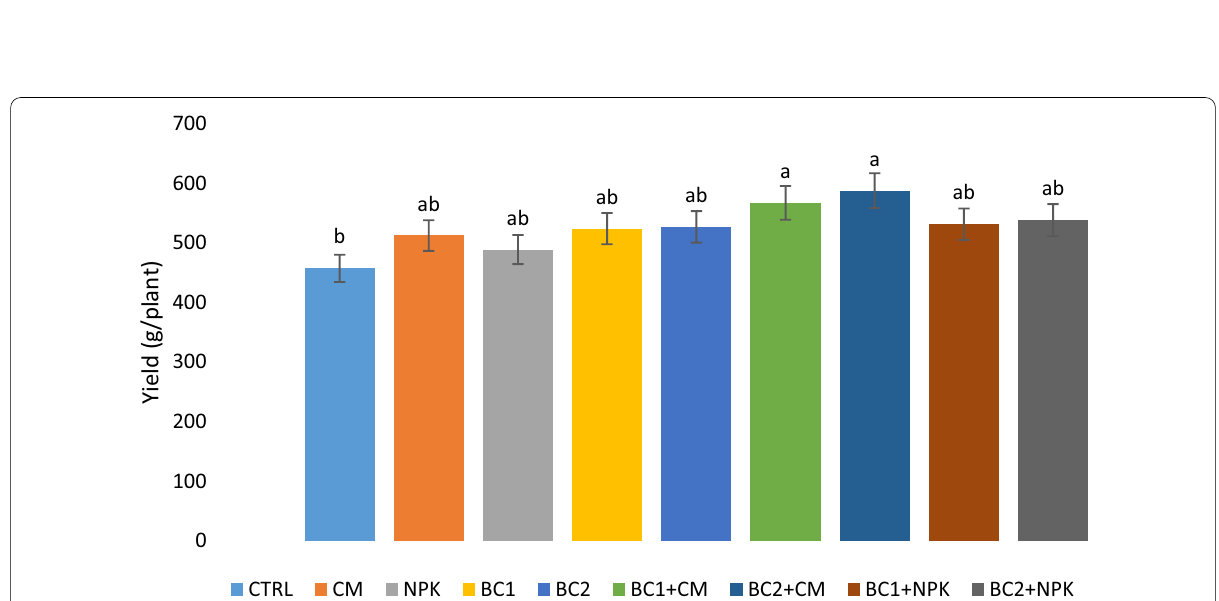
Fig. 3 Residual Effect of biochar, farmyard manure compost and/NPK on the collard plant yield. The same letter on the bars are not significantly different at p 0.0 5 using Tukey HSD; Control(CTRL), 10 t/ha compost only (CM), 200 kg NPK, 10t/ha Biochar only (BC1), 20 t/ha Biochar only (BC2), ≤ 5 t/ha Biochar 5 t/ha compost (BC1 CM), 10 t/ha Biochar 5 t/ha compost (BC2 CM), 5t/ha Biochar 100 kg/ha NPK (BC1 NPK), 10 t/ha + + + + + + Biochar 100 kg/ha NPK (BC2 NPK); Error bars represent standard deviation of the + +